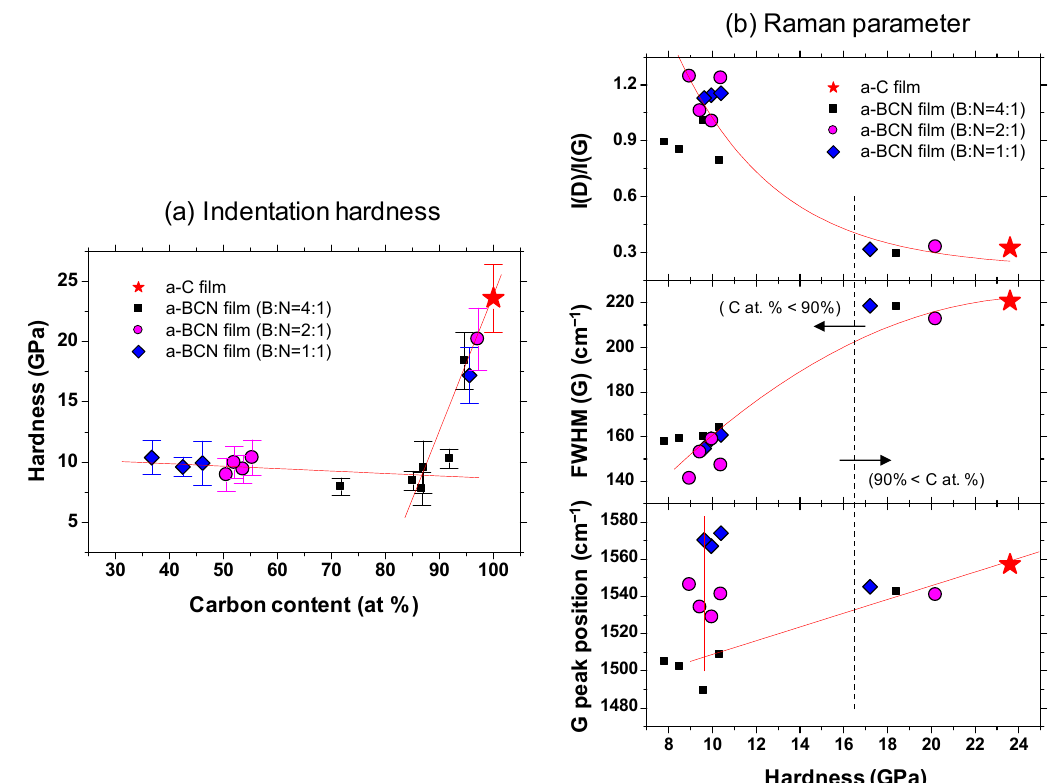
Figure 9. ( a ) Indentation hardness as a function of the carbon content; ( b ) Raman parameters with respect to the indenta- tion hardness.